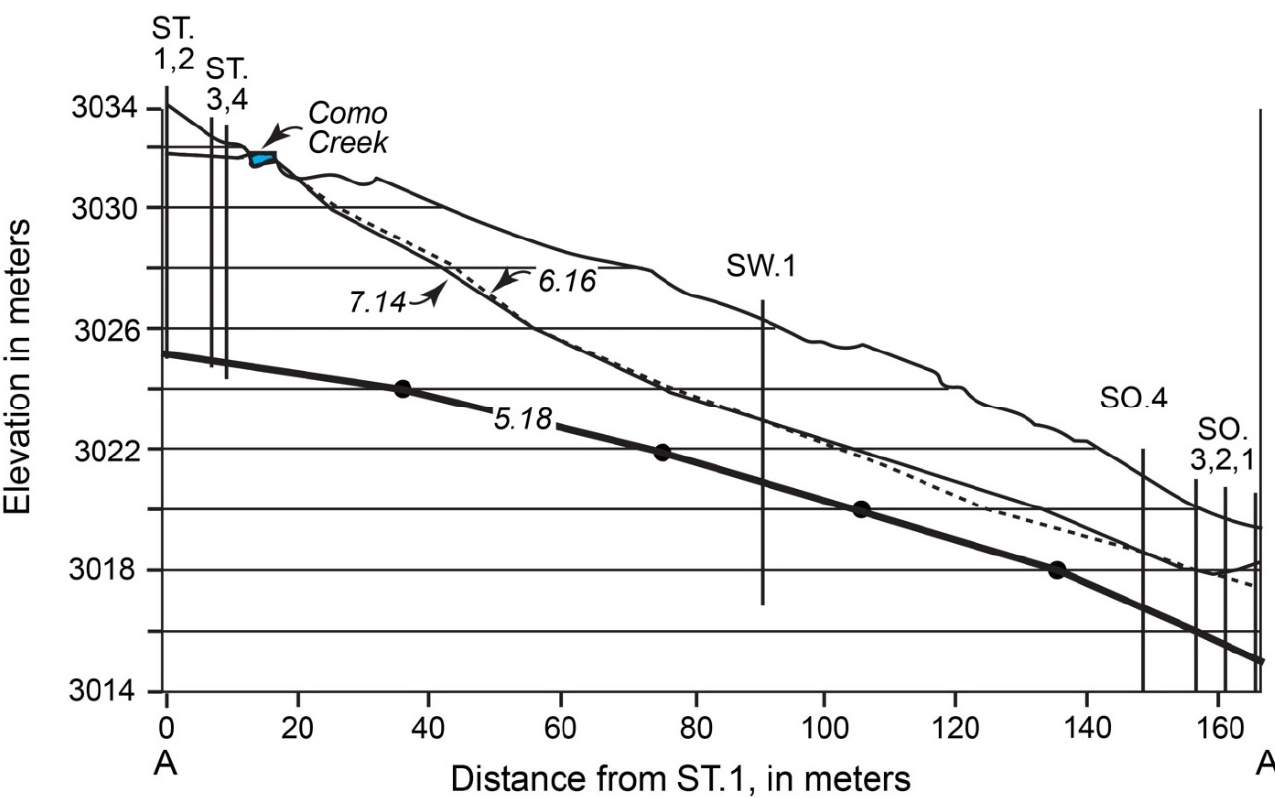
Figure 8. Daily water levels at C1 wells ST.1 and SW.2 in 2012–2016 (https://nwt.lternet.edu/data- catalog; accessed 10 December 2016). Snowmelt in 2013 was unusually low, 2014 was high and 2015 and 2016 were near average. Peaks in 2016 were perturbed by well tests from this study.